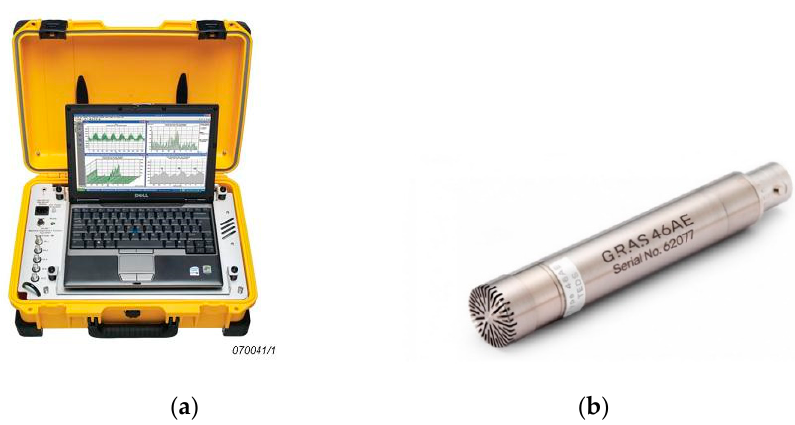
Figure 3. Sound measuring equipment. ( a ) Bruel and Kjær Type 9727 measuring equipment and ( b ) GRAS 46AE 1/2” CCP microphone.